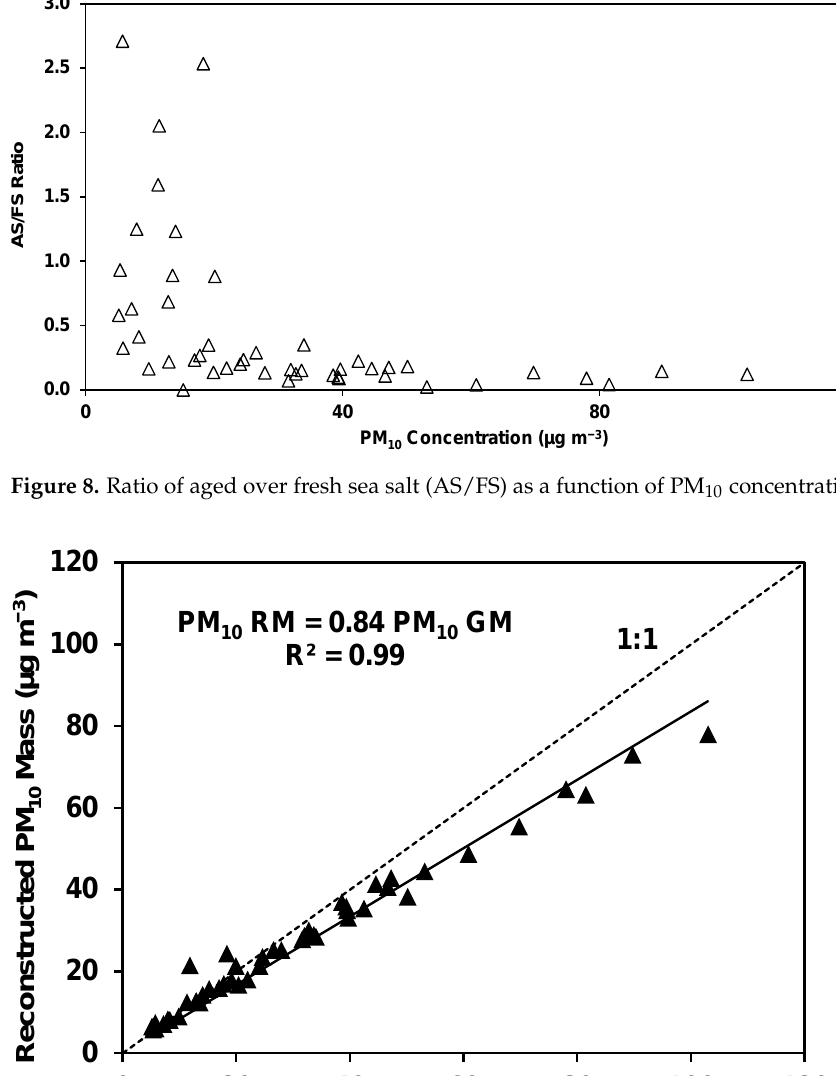
Figure 8. Ratio of aged over fresh sea salt (AS/FS) as a function of PM 10 concentration.